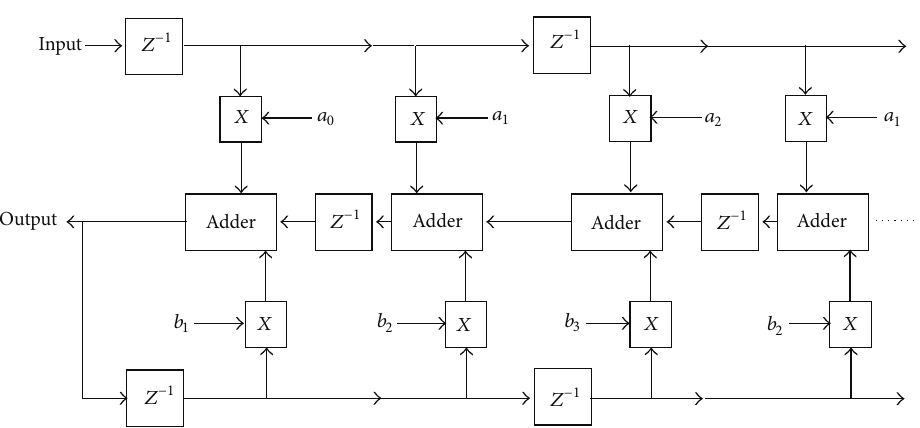
Figure 1: Systolic array architecture for digital